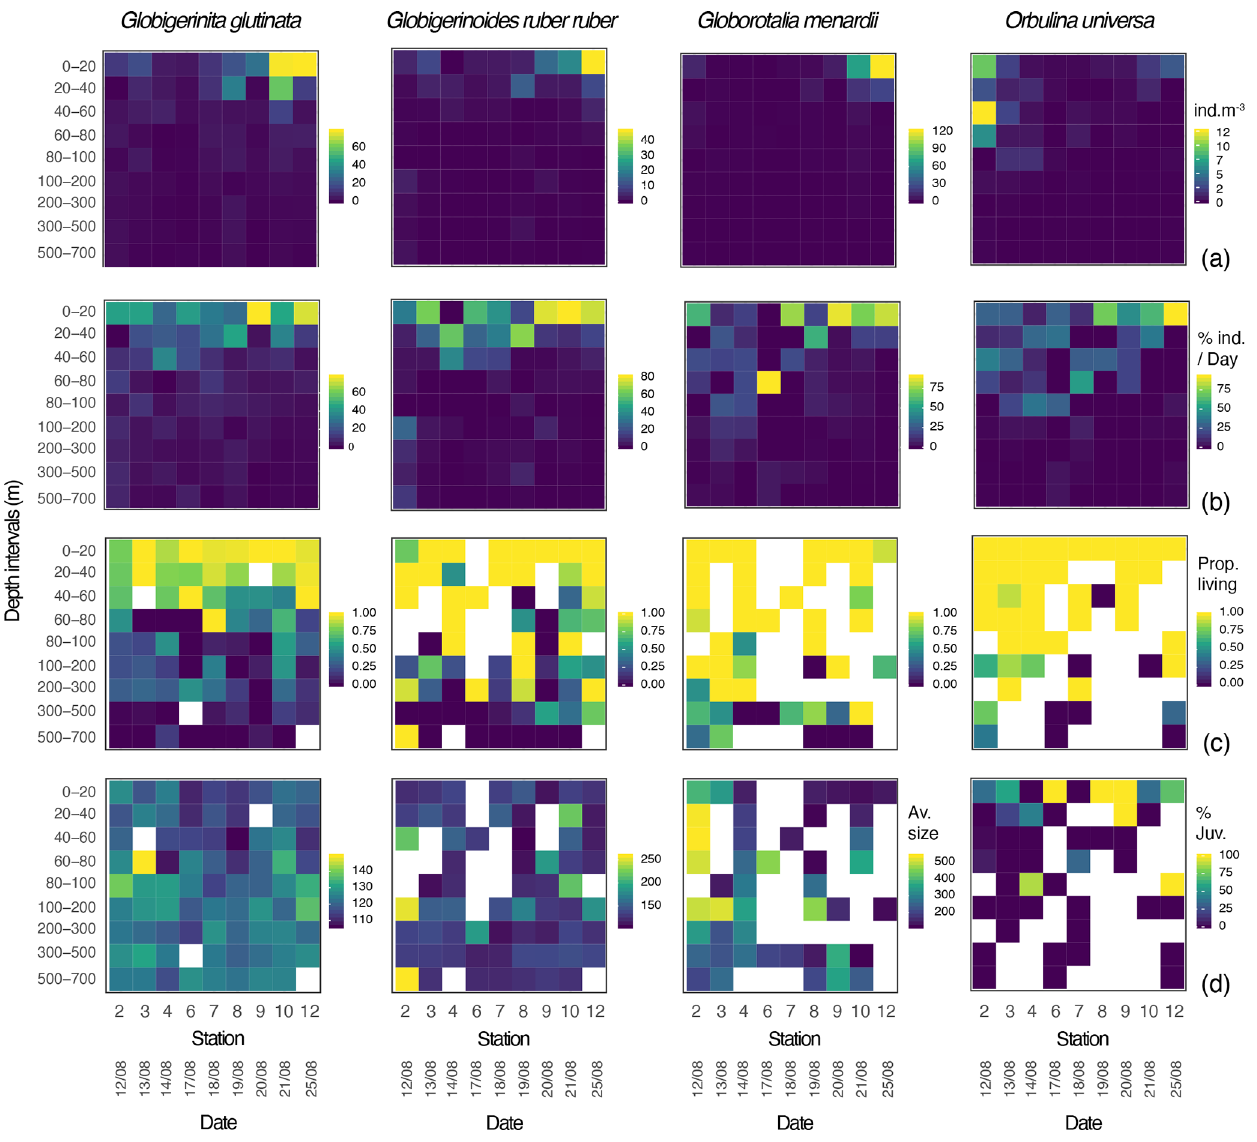
Figure 3. Globigerinita glutinata , Globigerinoides ruber ruber , Globorotalia menardii and Orbulina universa (a) abundances (individu- alsm − 3 ), (b) normalised abundances per day (%), (c) ratio between living and dead specimens, and (d) average size based on the minor axis (µm) and excluding all specimens smaller than 100µm, per depth interval ( y axis) and per station and date ( x axis). White squares represent the absence of specimens. For O. universa panel (d) displays the percentage of trochospiral specimens, with yellow indicating trochospiral specimens only and dark blue indicating spherical specimens